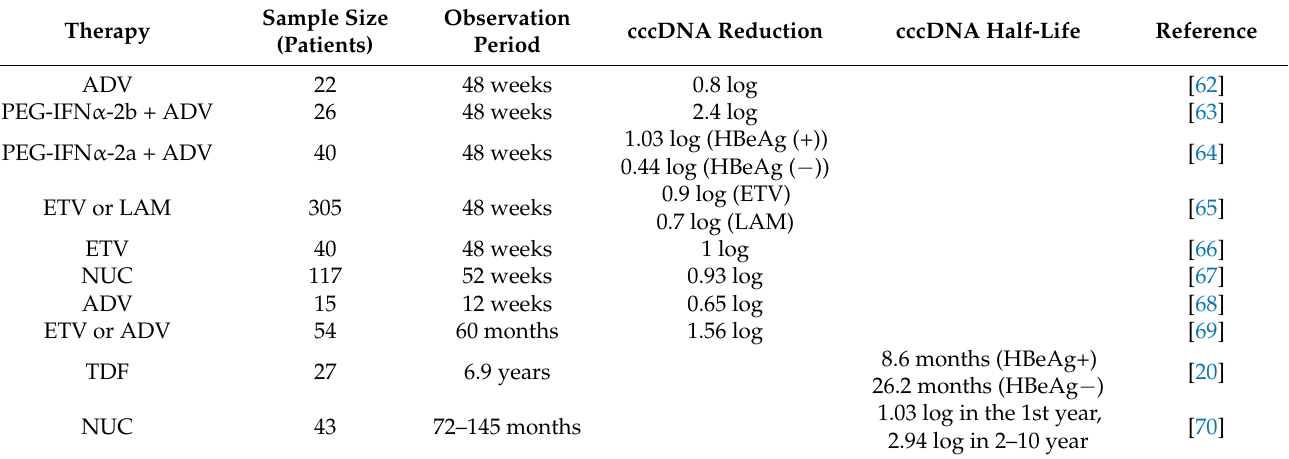
Table 2. cccDNA half-life during long-term